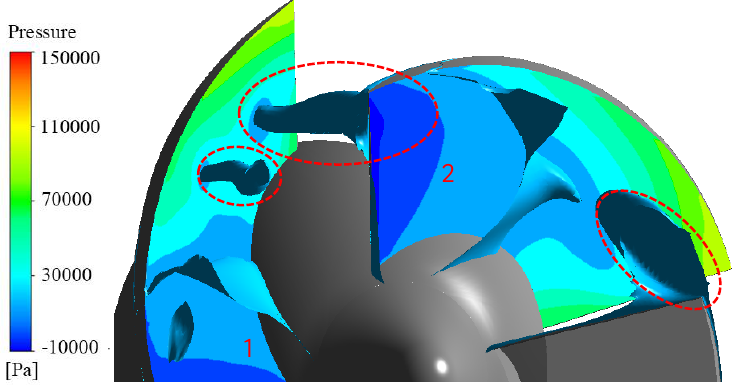
Figure 14. Pressure iso-surface of impeller passage at 8/12 T ( δ = 0.5 mm).